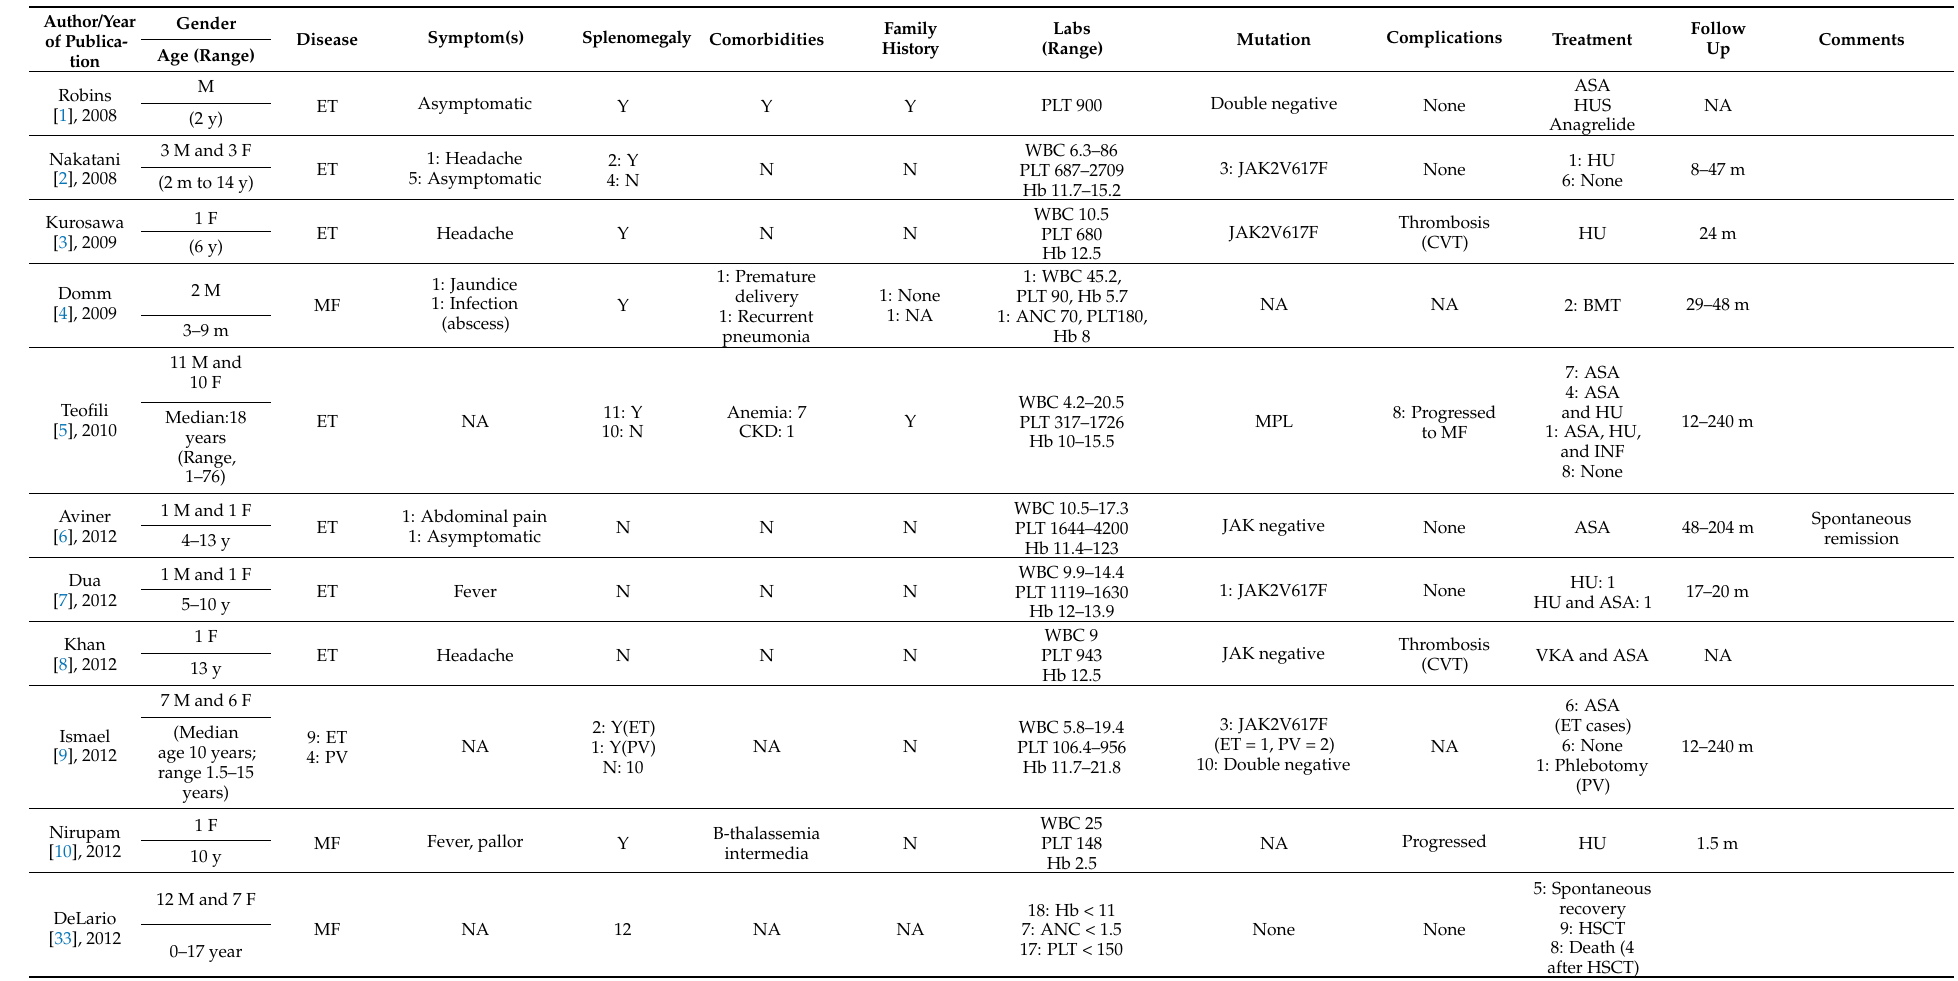
Table 1. Characteristics, outcomes, and treatment of patients with essential thrombocythemia, polycythemia vera, and myelofibrosis